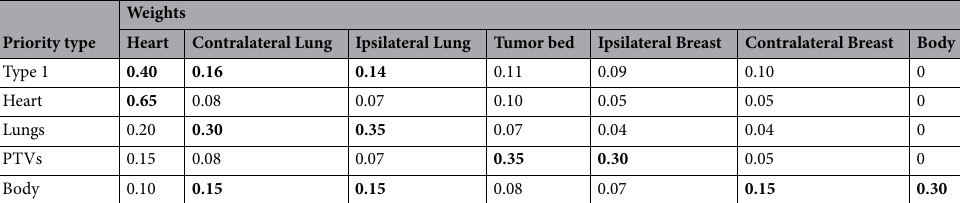
Table 5. Alternative sets of penalty weights. Transposed from Table 3 in: Wang X et al. 8 . Reproduced without change according to a Creative Commons Attribution 4.0 International License. Each row indicates a penalty type. The weights assigned to the structures related to a given priority type are chosen to sum to ≥ 0.65, highlighted in bold. PTVs, planning target